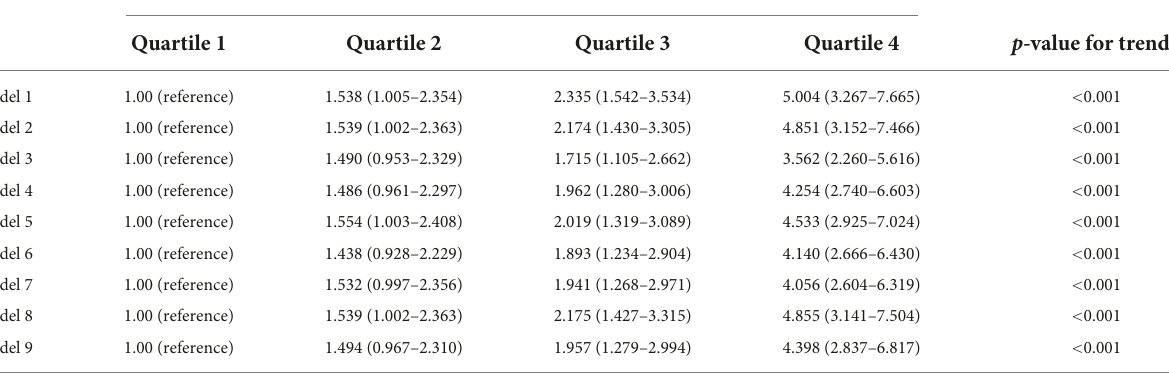
Serum tHcy levels a